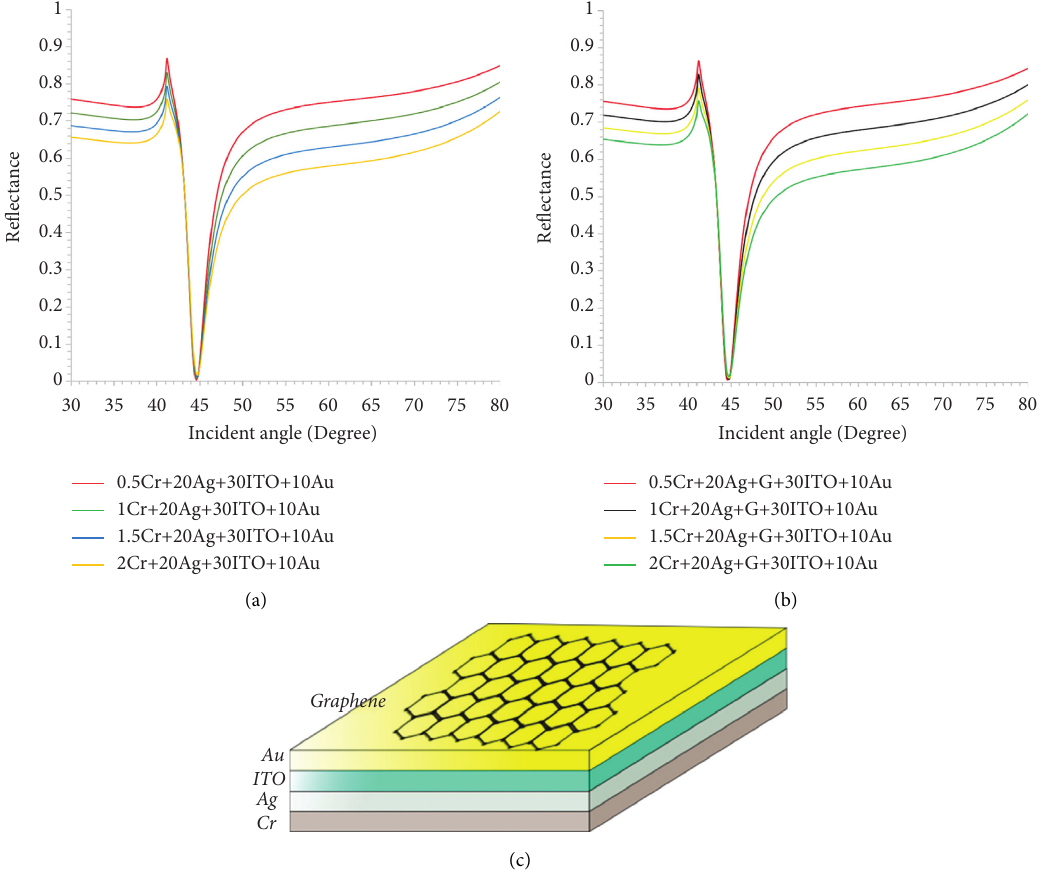
Figure 6: Reflectivity of two sensors with the Cr layer thickness ranging from 0.5 to 2 (unit: